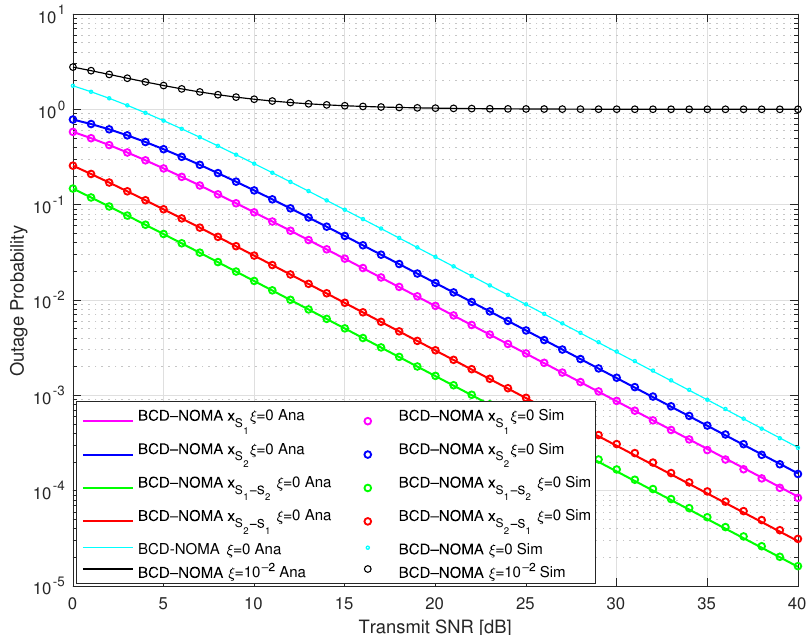
Figure 2. Outage probability of BCD-NOMA scheme.